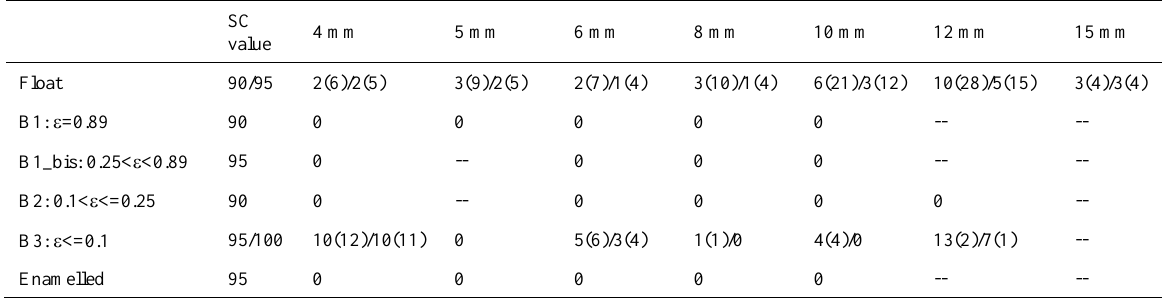
Table 7. Incidence value (%) and sample numbers () of NC data for SC (MPa) vs FR in TT with proposed SC value